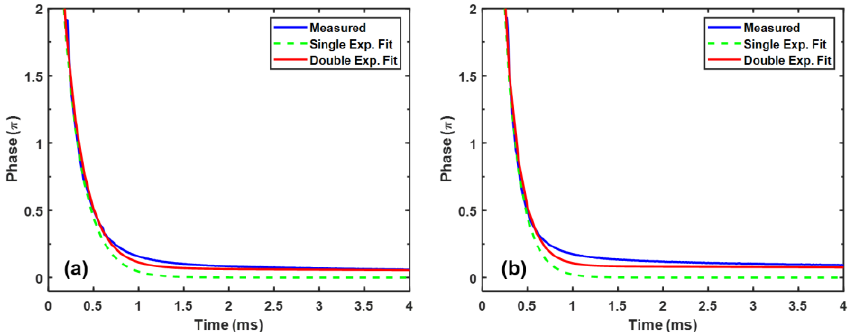
Figure 5. Time-dependent phase change curves of PNLC-4 and HTG-4 at λ = 1.06 µ m and 25 ◦ C: ( a ) PNLC-4, and ( b ) HTG-4.